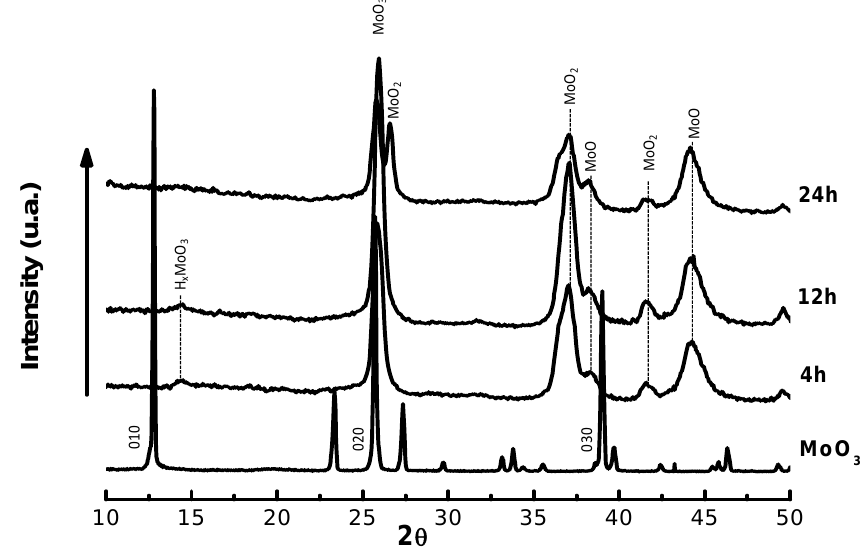
(JCPDS data file no. 05-0508) and 3 / n -C at 643 2 7